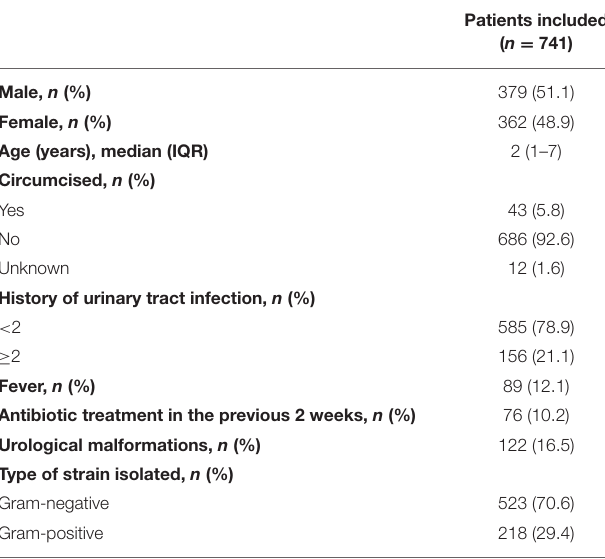
TABLE 1 | Baseline characteristics of the study population.